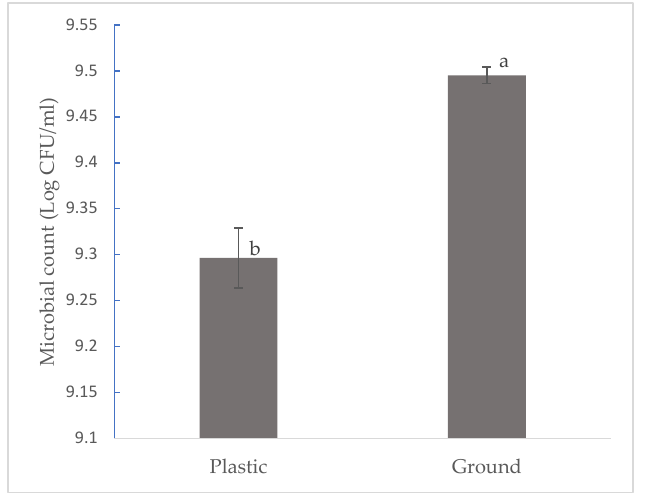
Figure 2. Effects of plastic mulch on Enterobacteriaceae microbial count in organic and conventional watermelon. a–b Mean with the same letters are not significantly different at p ˂ 0.05.